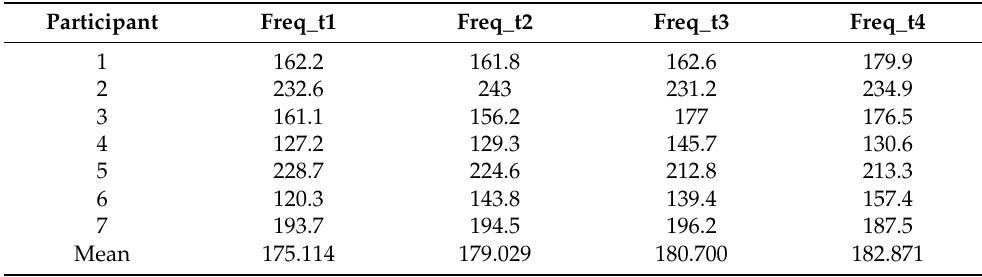
Table 15. Fundamental frequency (Hz) individual and mean measurements at four assessment time points.